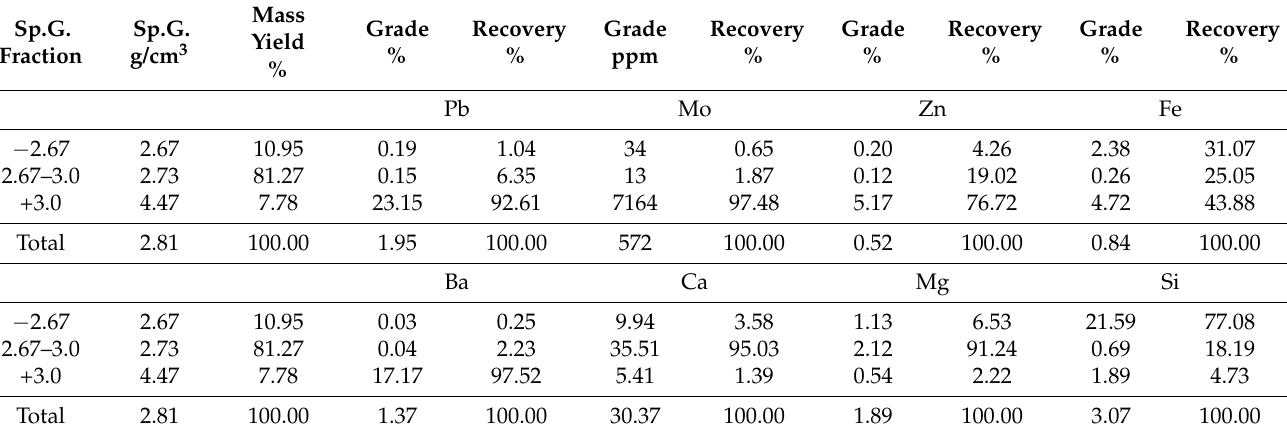
Table 7. Forecast results of gravity separation of the combined particle size fraction 0.04–1 mm— Sample A1 top.